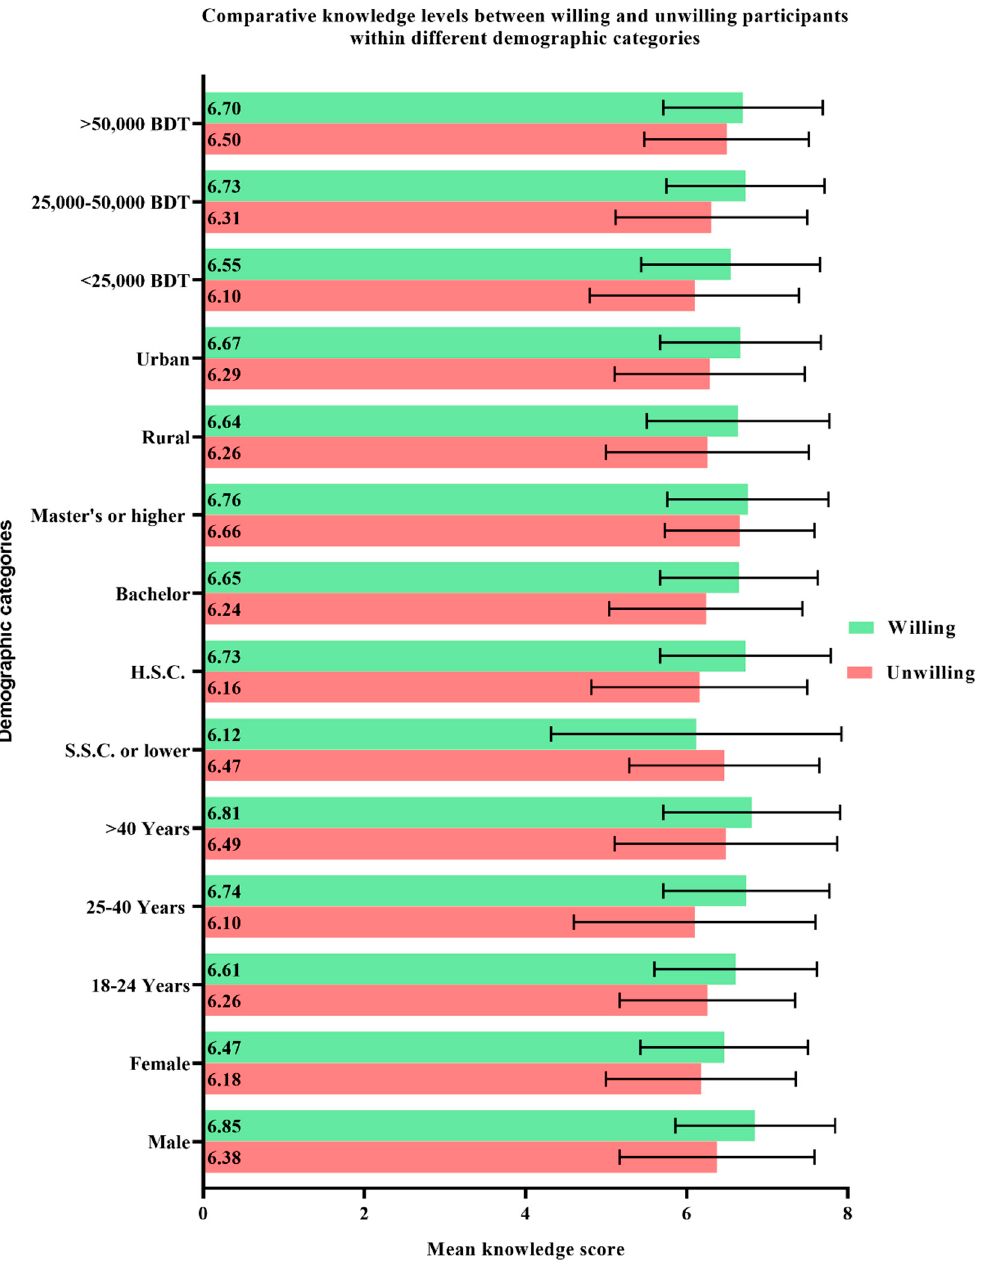
Figure 2. Comparative knowledge levels between willing and unwilling participants within different demographic categories expressed in terms of mean ± standard deviation.